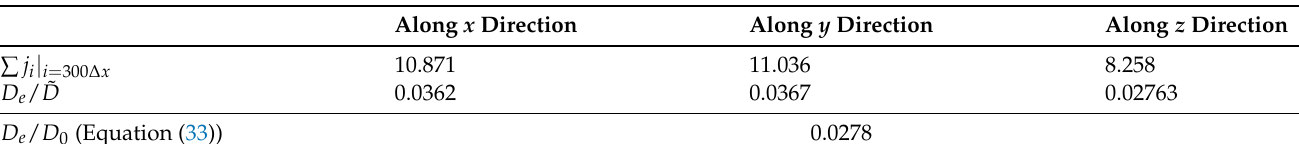
Table 2. The total sum of the normal to the wall component of the mass flux at the outlet along with the calculated D e for each